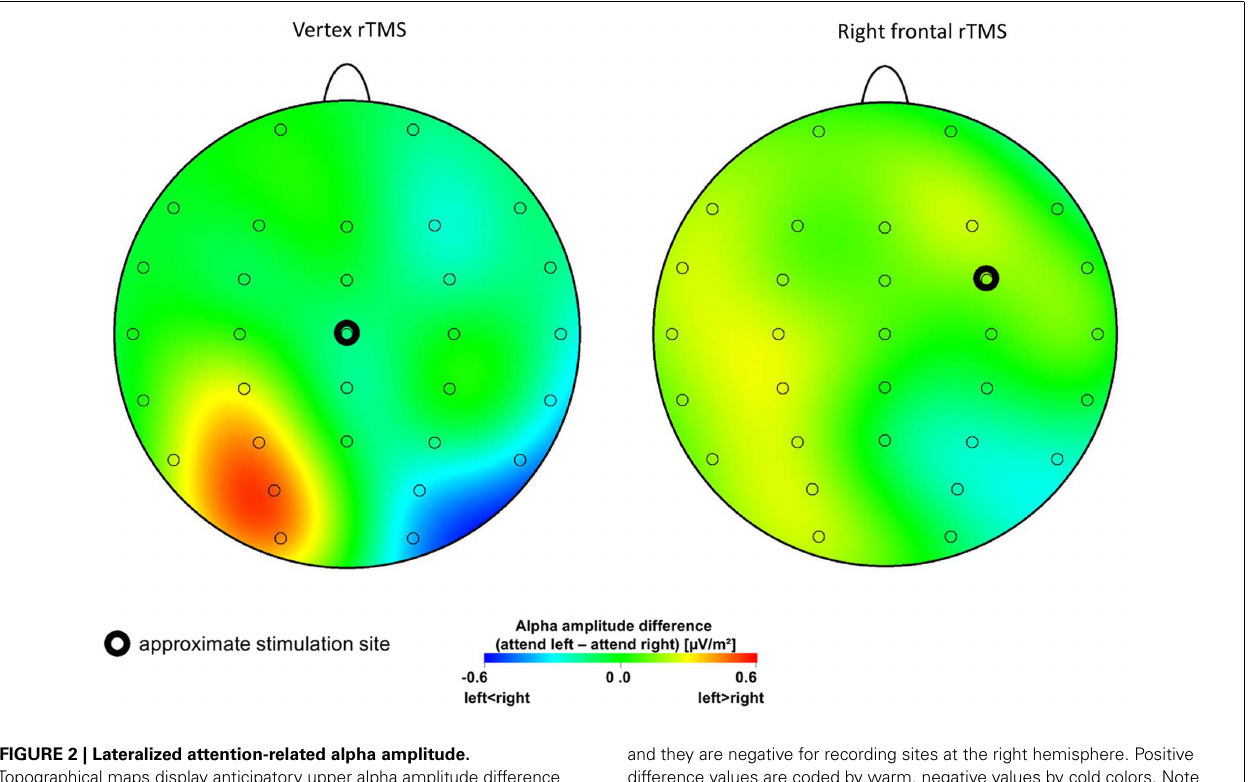
and they are negative for recording sites at the right hemisphere. Positive difference values are coded by warm, negative values by cold colors. Note that increased ipsilateral upper alpha amplitude at posterior recording sites as correlate of shifting visuospatial attention is only obtained after rTMS delivered at the control site.This pattern is absent after setting a virtual lesion at the right